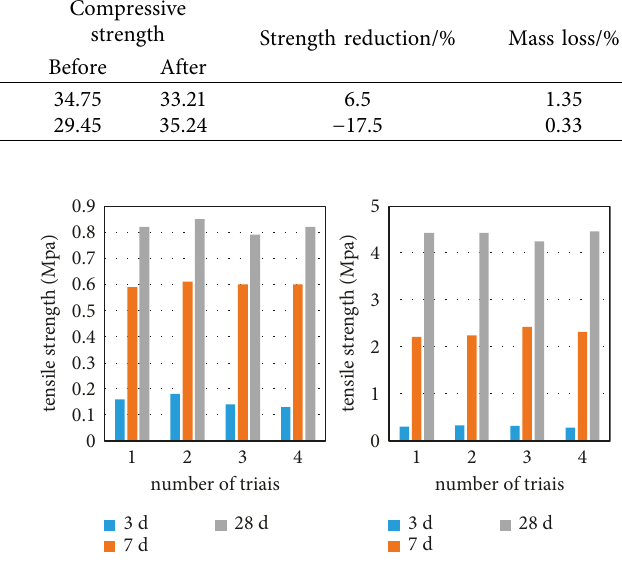
Figure 7: Tensile strength